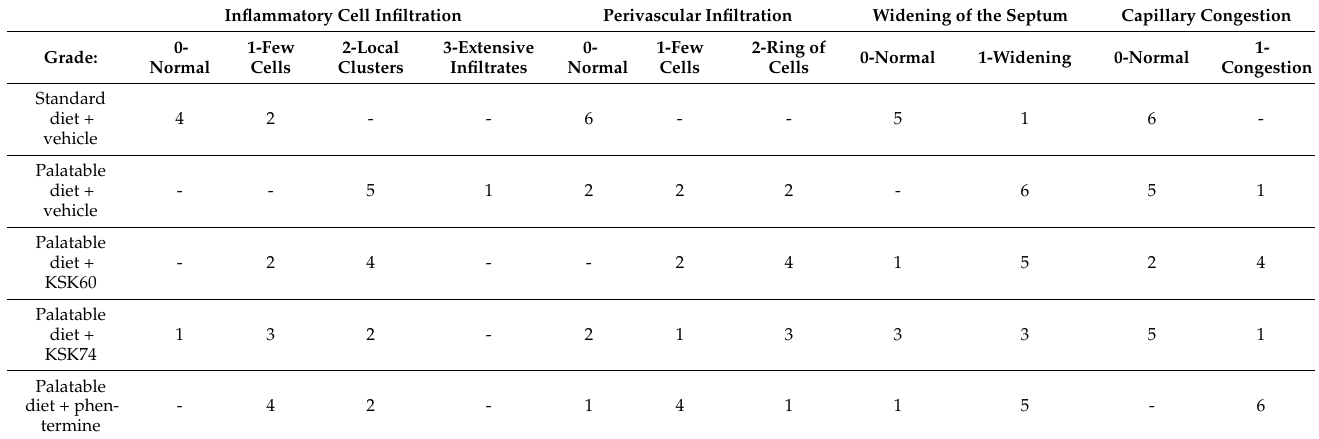
histological grade for the independently assessed components of the inflammatory.